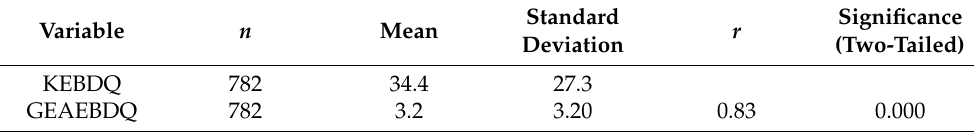
Significance Standard r (Two-Tailed) Deviation